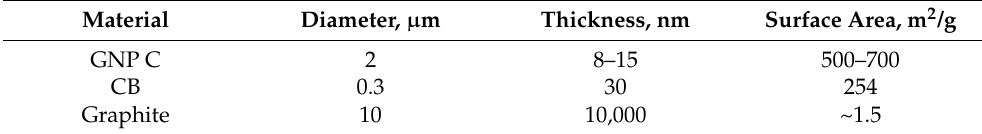
Table 2. Physical Properties of Chosen Carbon Materials.